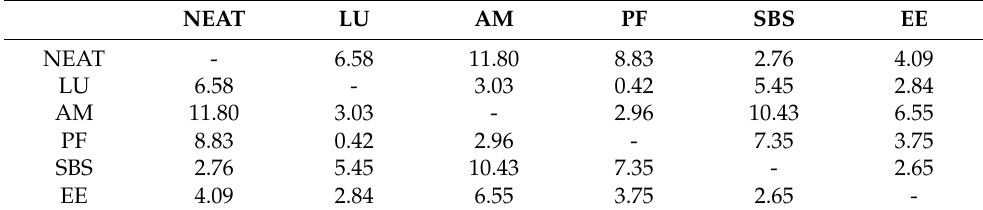
Table 11. Effect sizes dynamic modulus at the temperature of 54.4 ◦